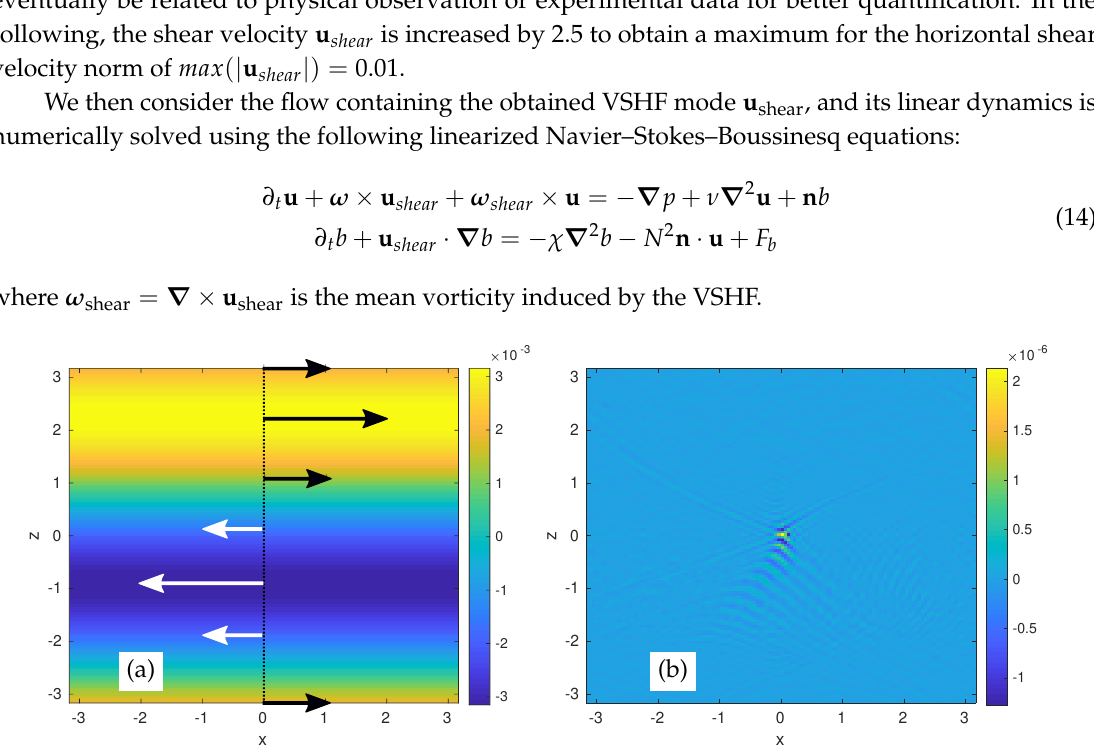
Figure 7. ( a ) Distribution of the horizontal component u shear , x of the VSHF in the ( x , z ) physical plane, obtained by direct numerical simulation of the linearized equations. ( b ) Distribution of the total vertical velocity in the physical vertical plane ( x , z )